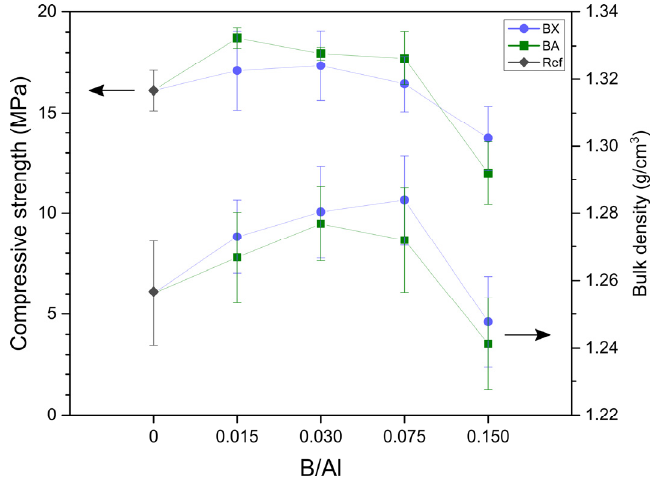
Figure 2. The compressive strength and bulk density of geopolymers with borax (BX) and boric acid (BA) as the source of boron (Ref—reference sample without boron).